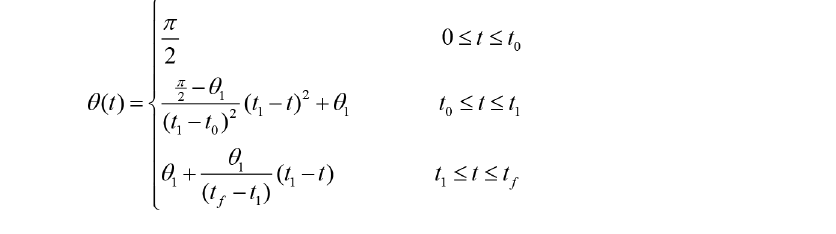
PITCHING PROGRAM OF THE SLV